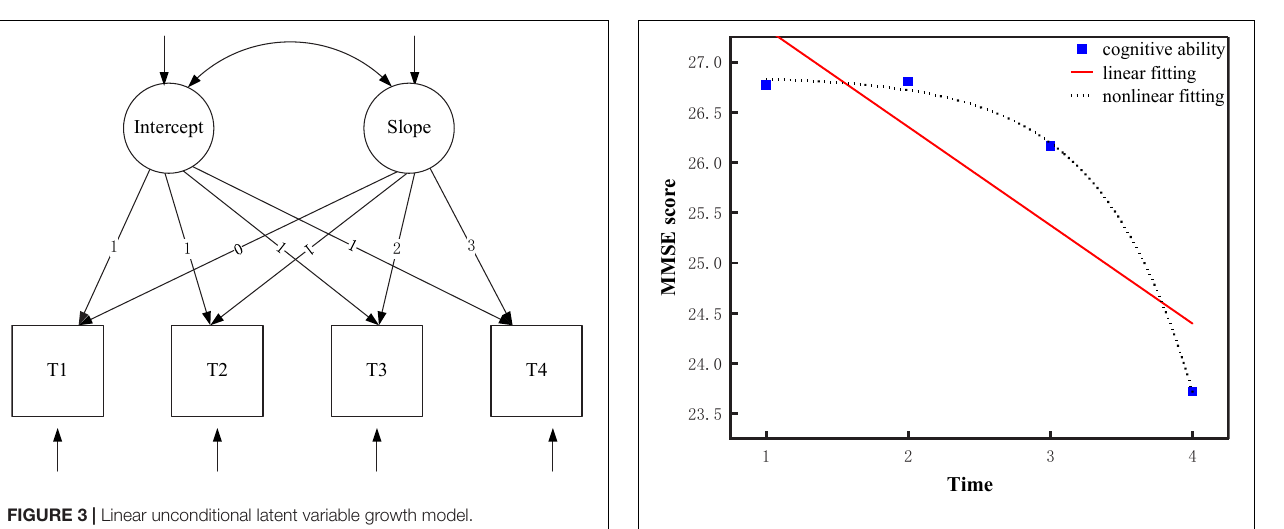
FIGURE 5 | Cognitive ability fitting.